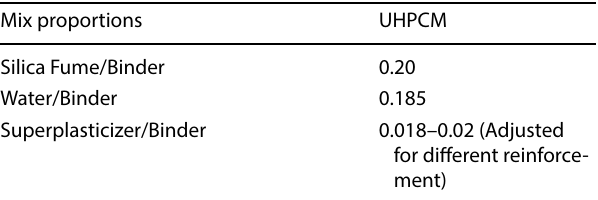
Table 2 The composition of the cementitious matrix selected for evaluation of the reinforcement efficiency of CBNs Mix proportions